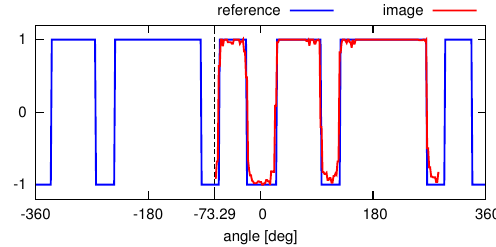
Figure 3: Target signal test and orientation determination. angles and the black/white alternation forms a periodic signal, as a function of the angle. Different codes can be obtained changing the position of the dots, allowing for multiple target tracking and for target scale resolution in case multiple replicas are